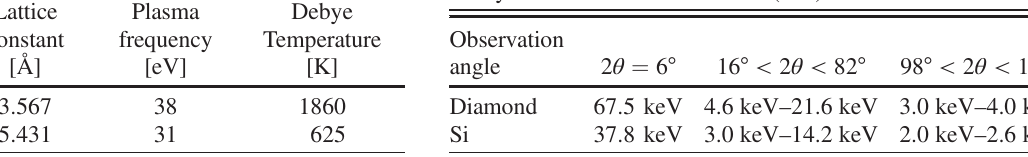
TABLE IV. PXR energy dependence of theta for diamond and Si crystals with the Miller index (111).